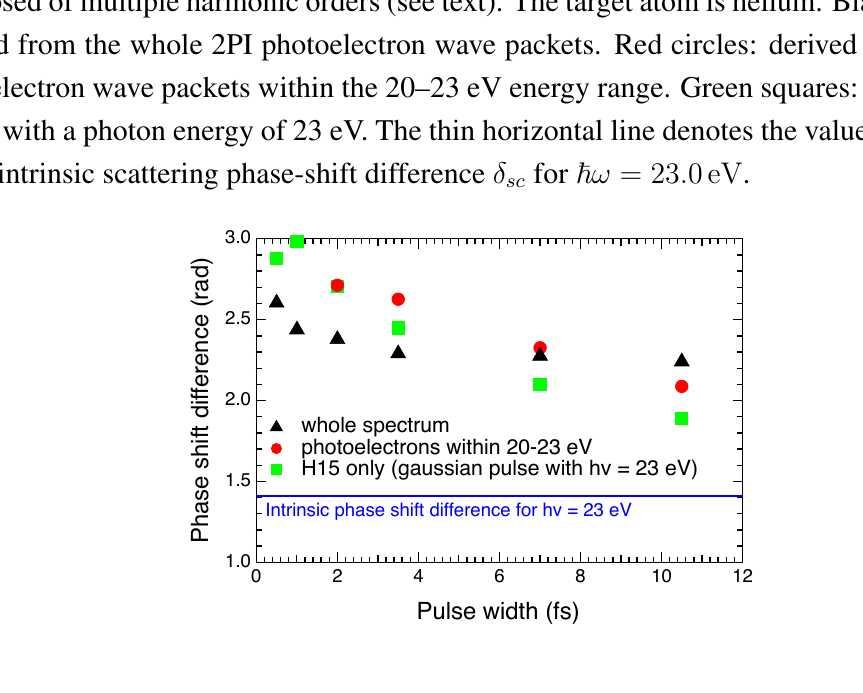
Figure 12. Pulse-width dependence of the photoelectron angular distribution for high-harmonic pulses. The target atom is